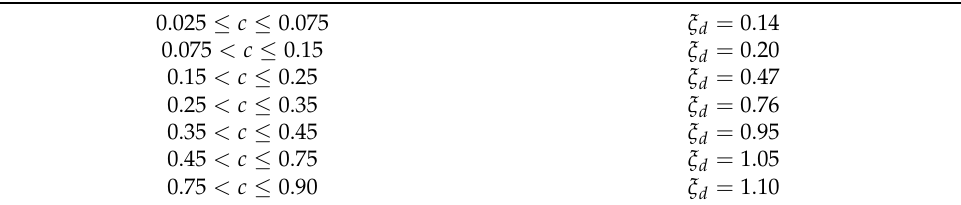
Table 3. Localized resistance coefficient as a function of the parameter c